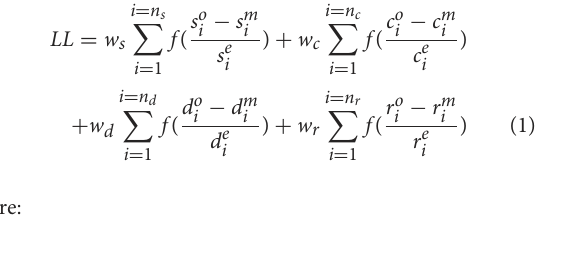
time series at each site: daily mean soil water content (m 3 /m 3 ), difference in daily mean soil water content over successive days (m 3 /m 3 /d), daily total drainage (mm/d), where available, and daily total surface runoff (mm/d) (assumed to be always zero). The standard errors of these measurements ( s i e , c i e , d i e , r i e , respectively) were assumed to be 0.02, 0.005, 1.0, and 1.0. Autocorrelation between the daily measurements was discounted by weighting the likelihood components with equal weights ( w s , w c , w d , w r , respectively) of 1/30. It is assumed that the residuals are not autocorrelated on a monthly (30 day) time scale (see Schoups and Vrugt, 2010), following Woodward et al.